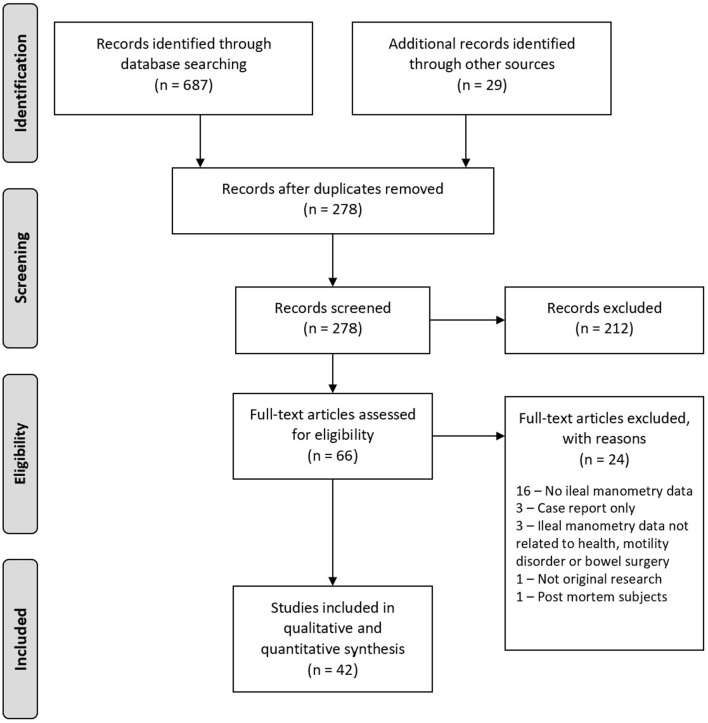
PRISMA flow diagram.